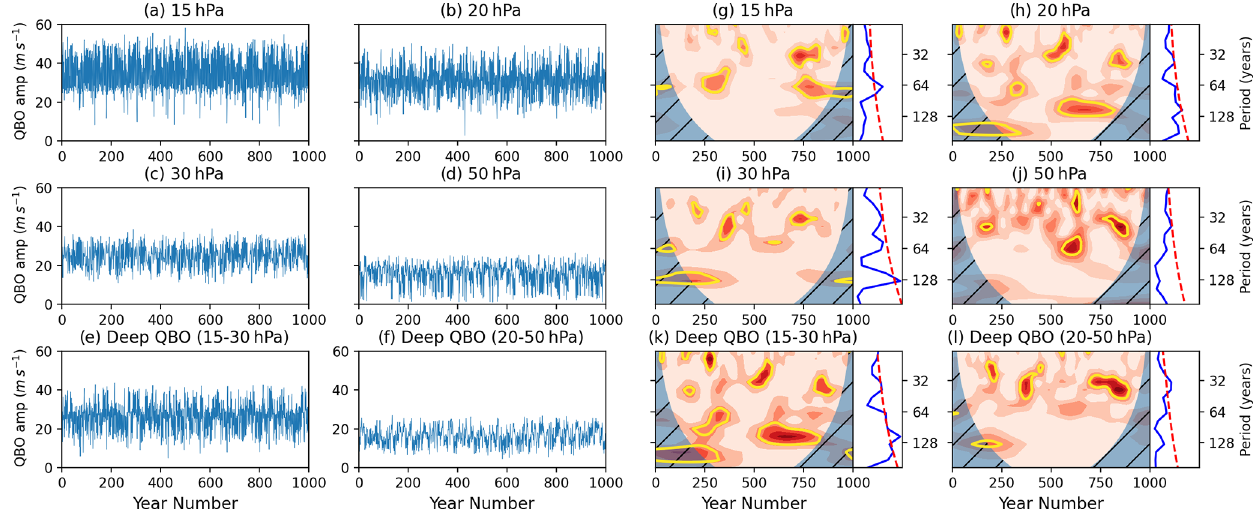
Figure 11. (a–e) Hilbert amplitude of September–November mean ZMZW averaged between 5 ◦ S–5 ◦ N latitude on different pressure lev- els (a–e) and the deep metric averaged between 15–30hPa (f) . (g–l) Wavelet power spectra for each time series shown in panels (a–c) . Shading represents wavelet power with a colour scale the same as that seen in Fig. 6, and yellow contours indicate regions of significant power ( > 95% confidence interval) compared to a background AR1 process.